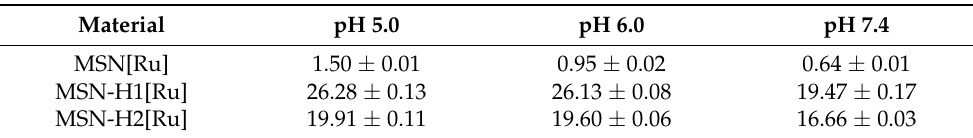
Table 2. The amounts of ruthenium ( µ g/mg MSN) released after 48 h of stirring, as measured by ICP-OES.